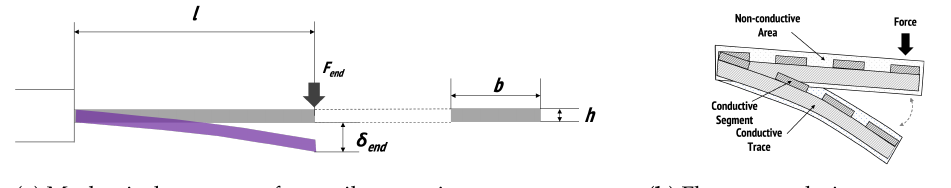
Figure 6. ( a ) Mechanical structure of cantilever spring. ( b ) The structural change of flex sensor- embedded cantilever spring when force is applied at the